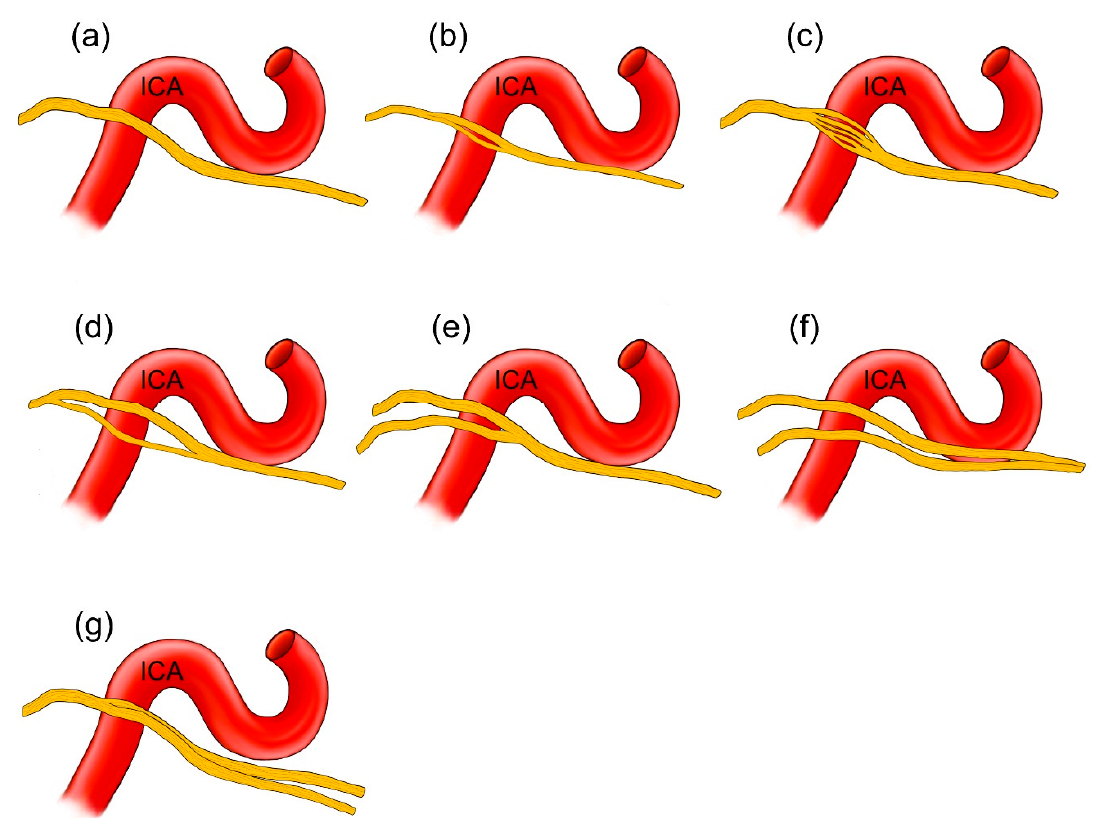
Figure 10. Schematic drawings illustrating anatomical variations of the AN. The nerve is colored yellow. ( a ) The most common variant found was a single nerve trunk. ( b , c ) Branching of the nerve into separate rootlets (“pseudobranching”) at the crossing site with the posterior vertical portion of the cavernous part of the ICA. This variant is seen only at the nerve’s cavernous segment. ( d – f ) show AN duplication. In ( d ), a single nerve enters the petroclival venous confluence. Variants ( d , e ) represent two separate parts of the duplicated AN merging within the CS. In another anatomical variant ( f ), two nerve trunks travel the entire intracranial course of the AN. ( g ) Early division of the AN into two branches before entering the orbit.